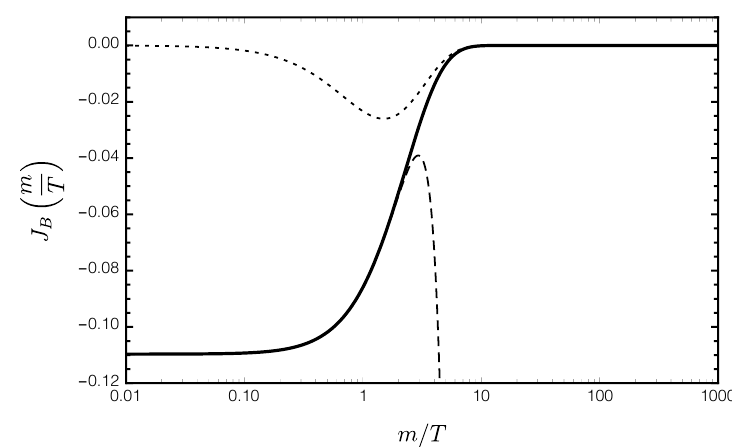
that is proportional to the B